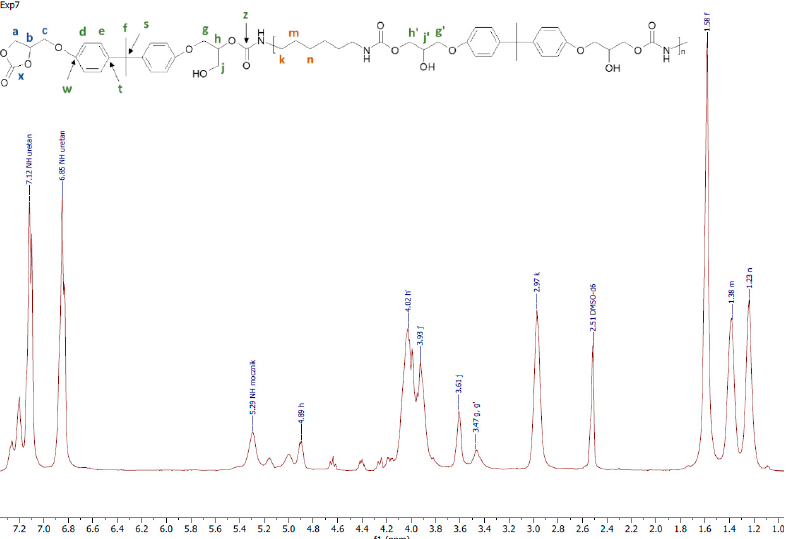
Figure 5. A representative 1H NMR spectrum of PHU obtained in experiment run nos. 7, 8, 11 and 12.